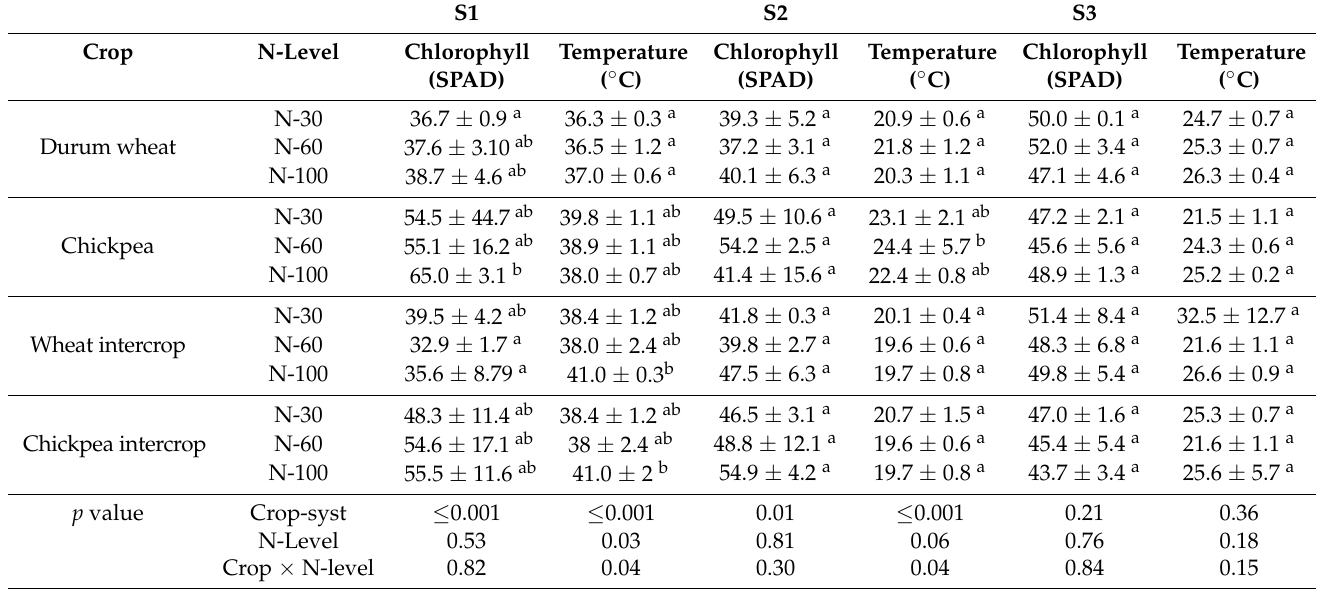
Data are means ± standard error of 4 replicates. Mean values labeled with the same letter were not significantly different at p <